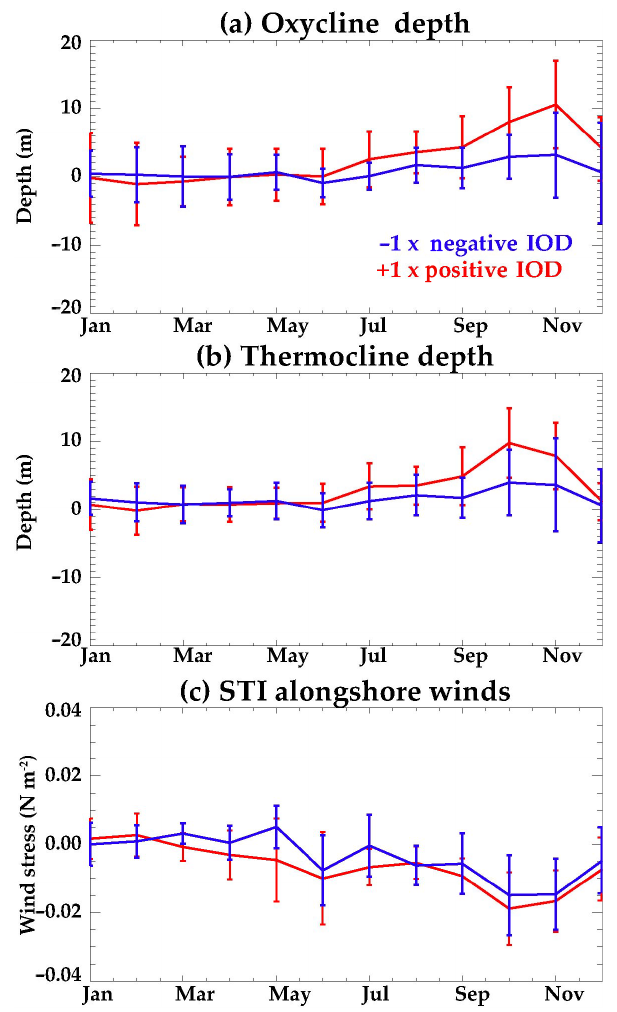
Figure 13. Seasonal evolution of anomalous composites of (a) WCI OCD, (b) WCI TCD, and (c) STI zonal wind stress during positive (red) and negative (blue) IOD events. Positive (negative) IODs are defined when the DMI averaged for the fall season is greater (lesser) than 1 ◦ C. The whiskers indicate the 95% confidence interval on the composited value. Positive IOD events considered in this composite are the years 1961, 1963, 1967, 1972, 1977, 1982, 1994, 1997, and 2006, while negative ones are 1964, 1973, 1974, 1975, 1979, 1981, 1984, 1992, 1996, 1998, and 2010. Negative IOD composite time series has been multiplied by − 1 to ease comparison with positive